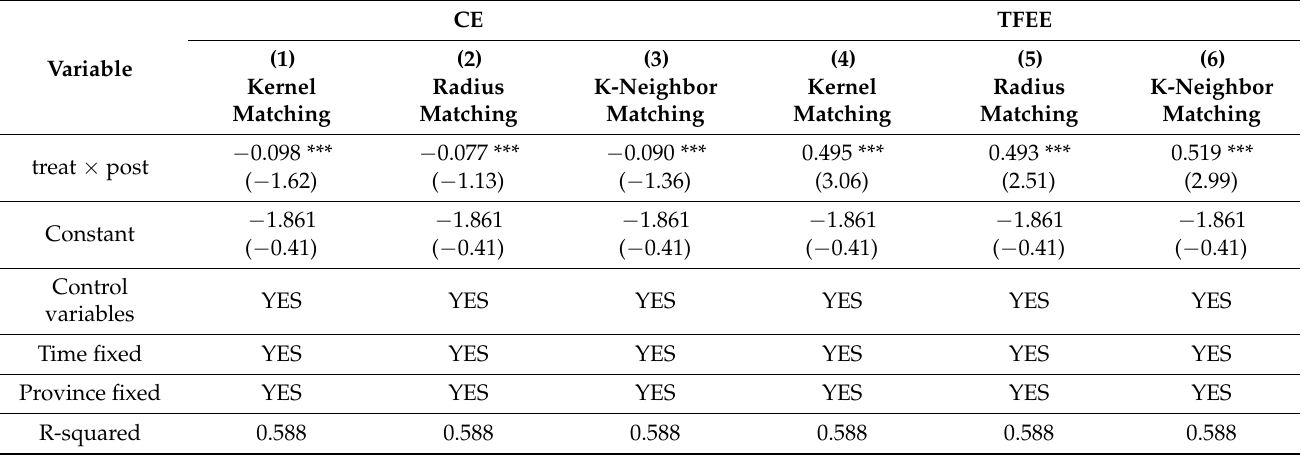
Table 4. PSM–DID test